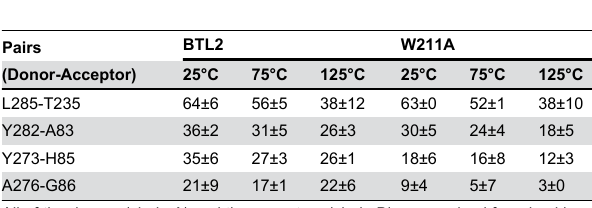
Table 2. Percent occupancy of the hydrogen bonds at subunit interface.